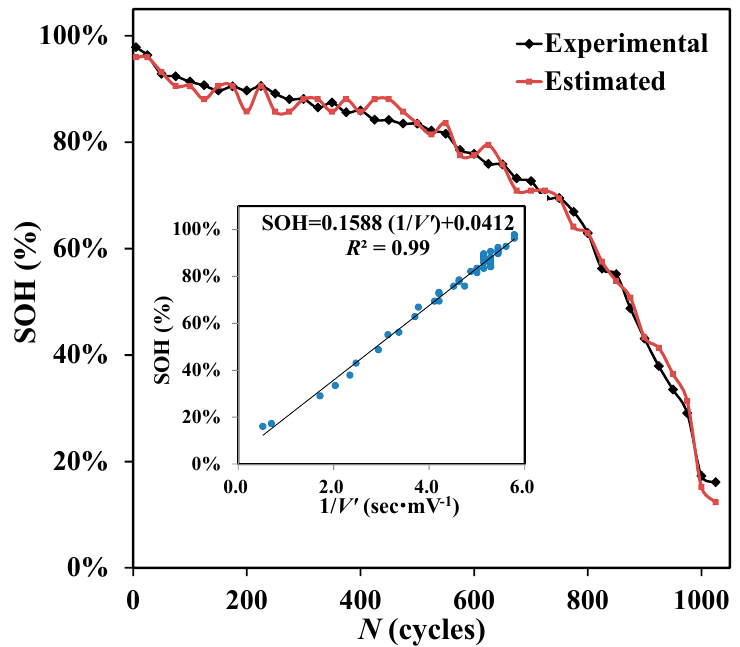
Figure 4. Comparison of the estimated vs. real SOH for cell A at SOC =